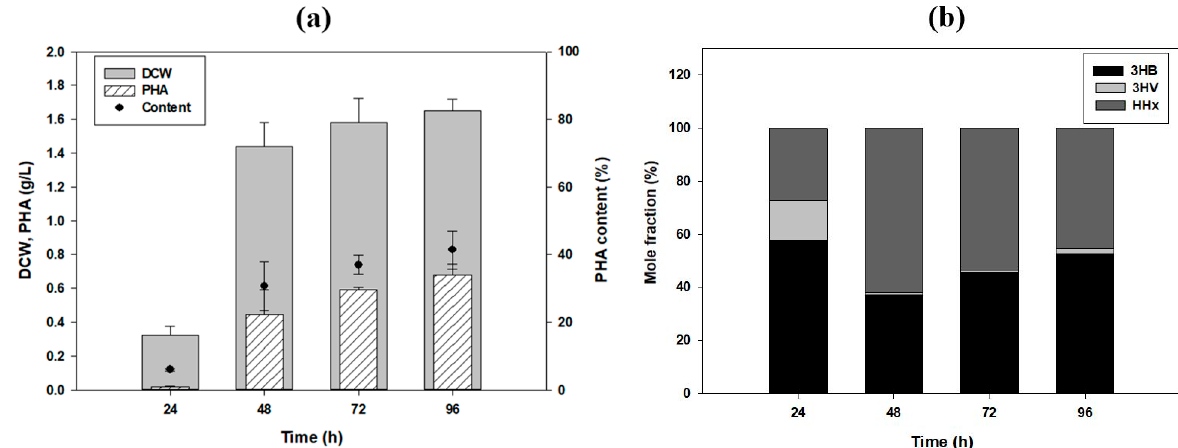
Figure 3. Monitoring of terpolymer production over time using tung oil as the carbon source. ( a ) biomass, polyhydrox- yalkanoate (PHA) accumulation; ( b ) PHA monomer composition. 3HB, 3-hydroxybutyrate; 3HV, 3-hydroxyvalerate; DCW, dry cell weight; HHx, 3-hydroxyhexanoate; OD, optical density. Table 1. Comparison of fatty acid composition of tung oil before and after